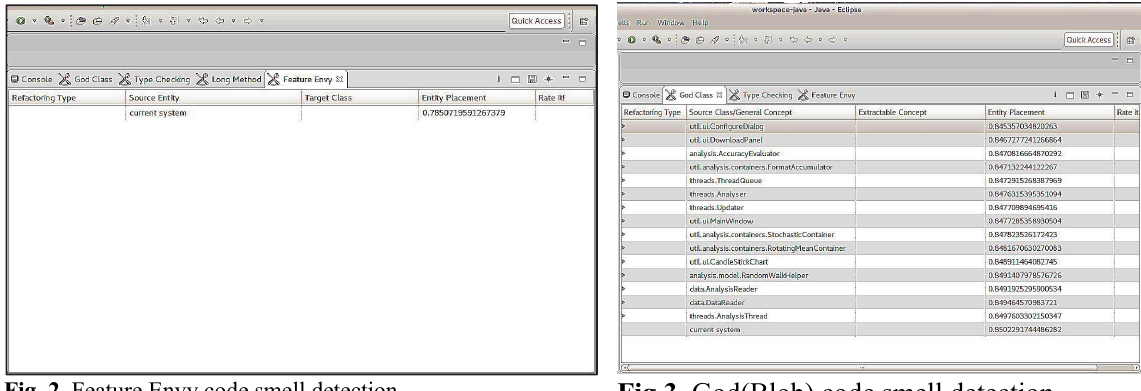
Fig. 2. Feature Envy code smell detection Fig 3. God(Blob) code smell